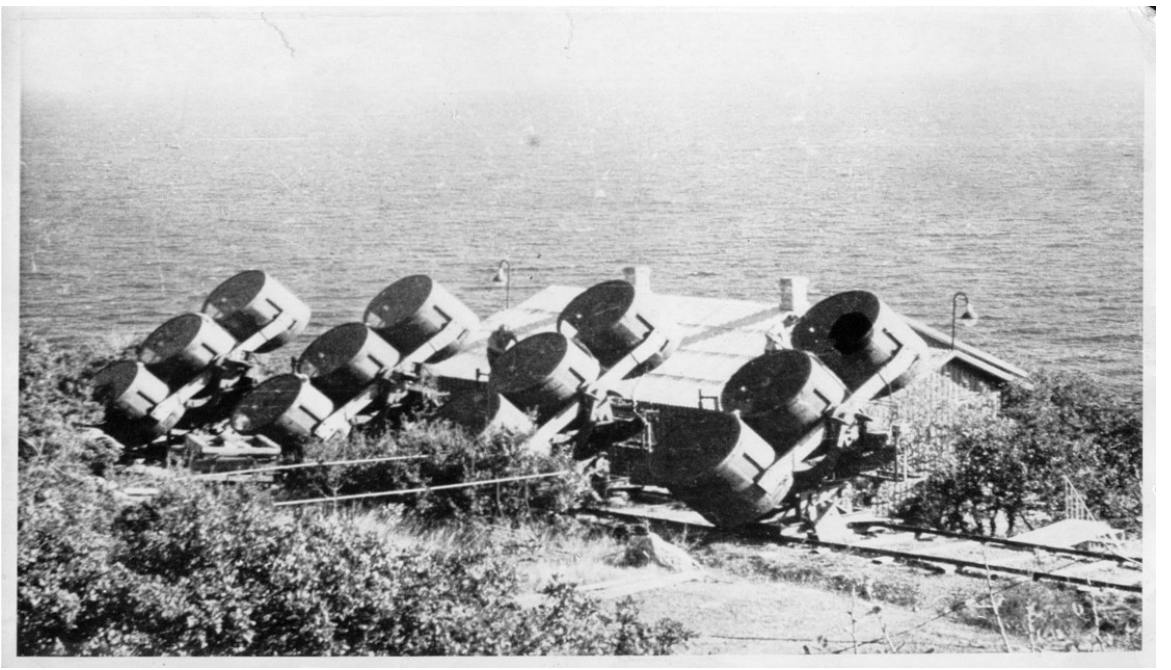
Figure 3. The telescope of A. Chudakov and colleagues in Crimea near the Black Sea shore.